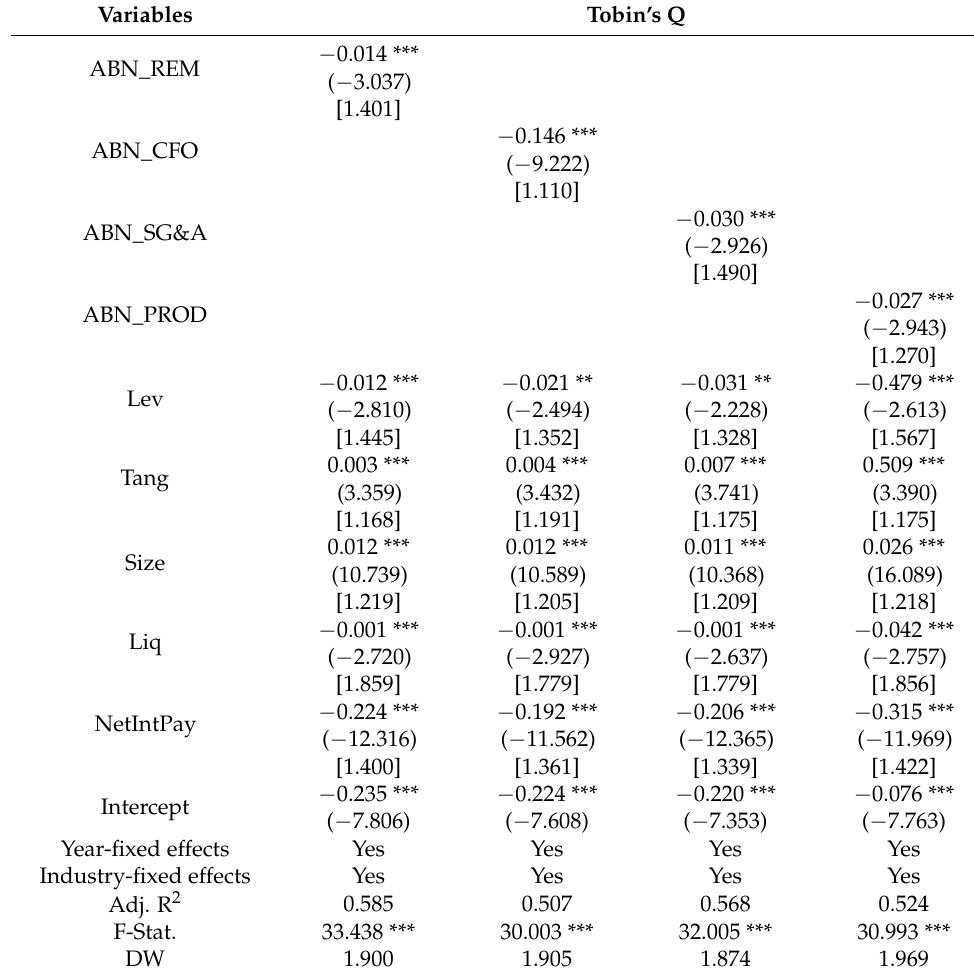
Table 3. Relationship between FV and